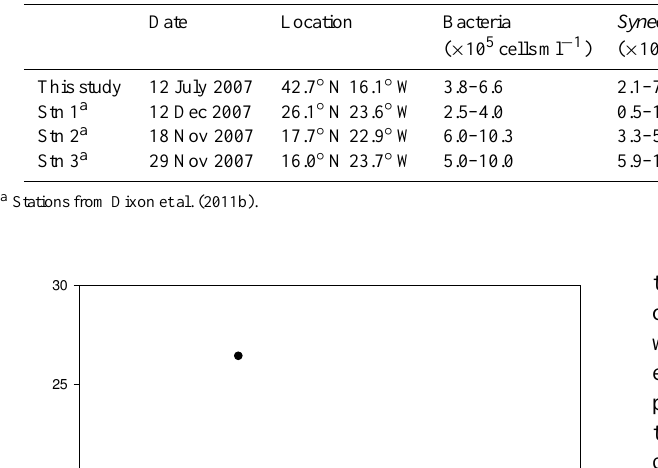
Table 2. Summary of diel stations.